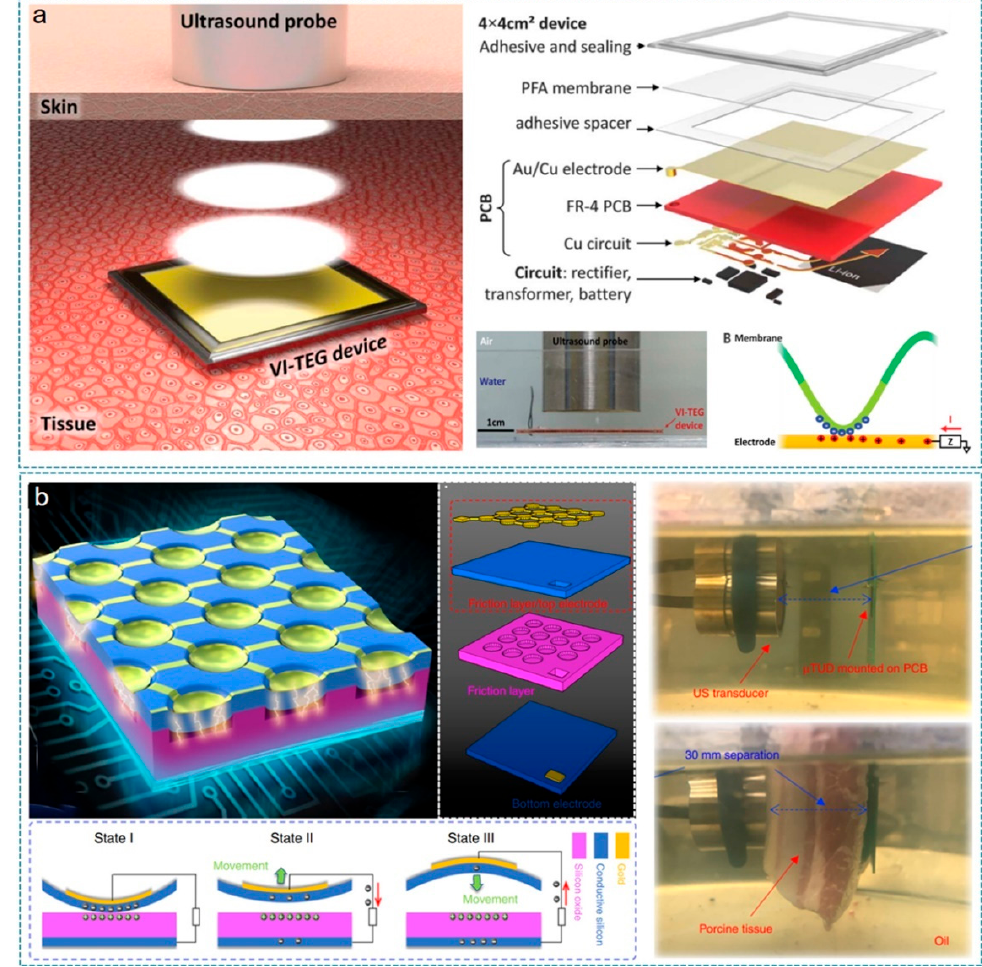
Figure 5. Ultrasound-driven energy harvester. ( a ) Ultrasound energy harvesting under skin based on triboelectric effects. Illustration of US energy harvesting under skin using the vibrating and implantable triboelectric generator (VI-TEG, left). The structure diagram and working principle of the VI-TEG (right). Reprinted with permission from Ref. [106]. Copyright 2019 American Association for the Advancement of Science. ( b ) Micro triboelectric ultrasonic device for acoustic energy transfer. Reprinted from Ref. [155]. Copyright 2020 Springer Nature.